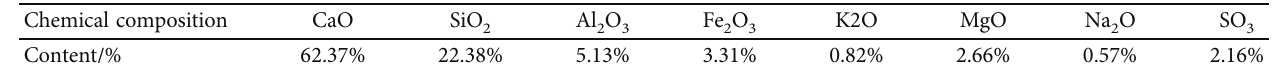
Table 2: Chemical composition of ordinary Portland cement.